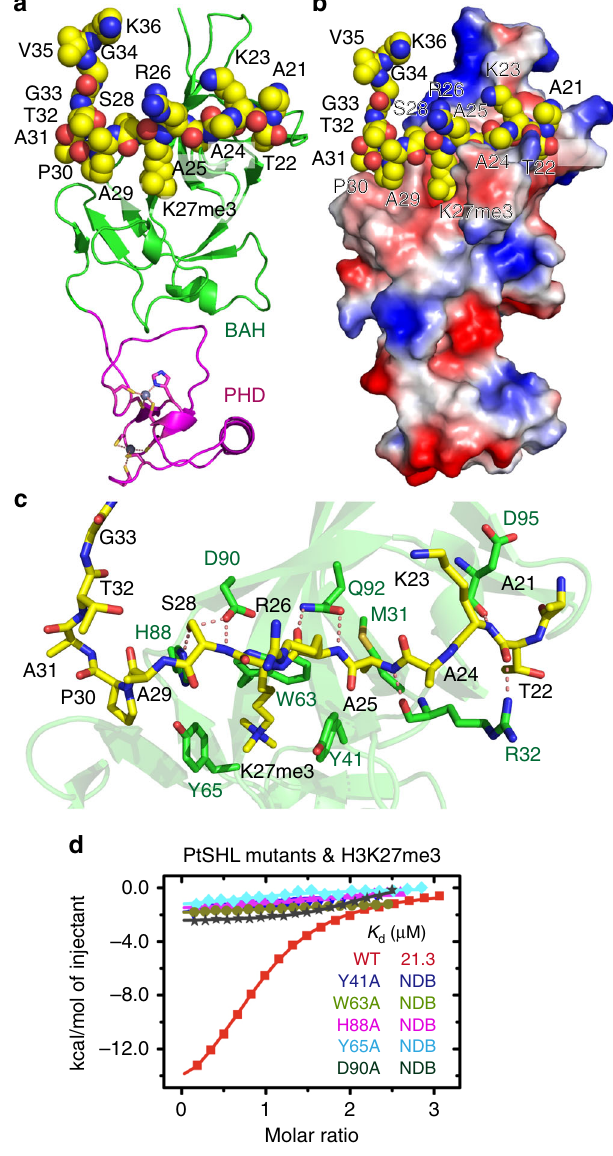
Fig. 3 Structure of PtSHL in complex with H3K27me3. a Overall structure of PtSHL in complex with H3K27me3 peptide. The bromo-adjacent homology (BAH) and plant homeodomain (PHD) domains are colored in green and magenta, respectively. The peptide is shown in space fi lling representation. b Electrostatic surface view of the PtSHL in complex with H3K27me3. c Details of the speci fi c recognition of H3K27me3 by an aromatic cage of BAH. The hydrogen-bonding interactions are highlighted with dashed red lines. d ITC binding curves between PtSHL mutants and H3K27me3 peptides reveal that the mutations of key H3K27me3 recognition residues impair the binding. NDB, no detectable